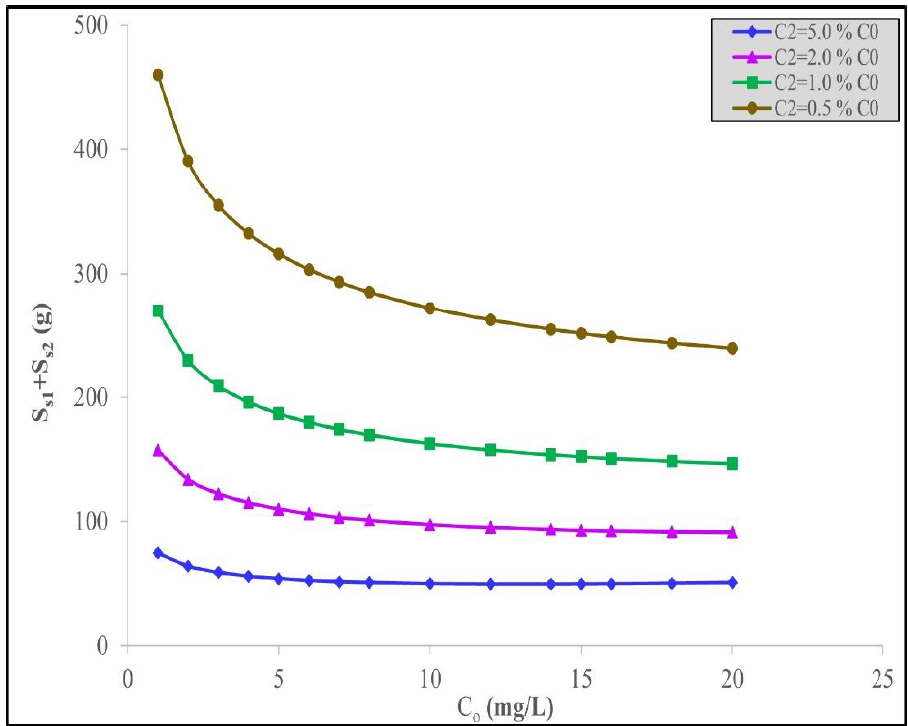
Figure 5. Minimum total quantity of acid-treated date stone activated carbon, S 1 + S 2 , against the initial IBU concentration, C 0 , to remove a fixed% C 0 IBU using the Langmuir – Freundlich model. Table 6. Minimum total quantity of date stone acid-treated activated carbon to remove IBU using the Langmuir–Freundlich model to achieve C 2 = 0.20